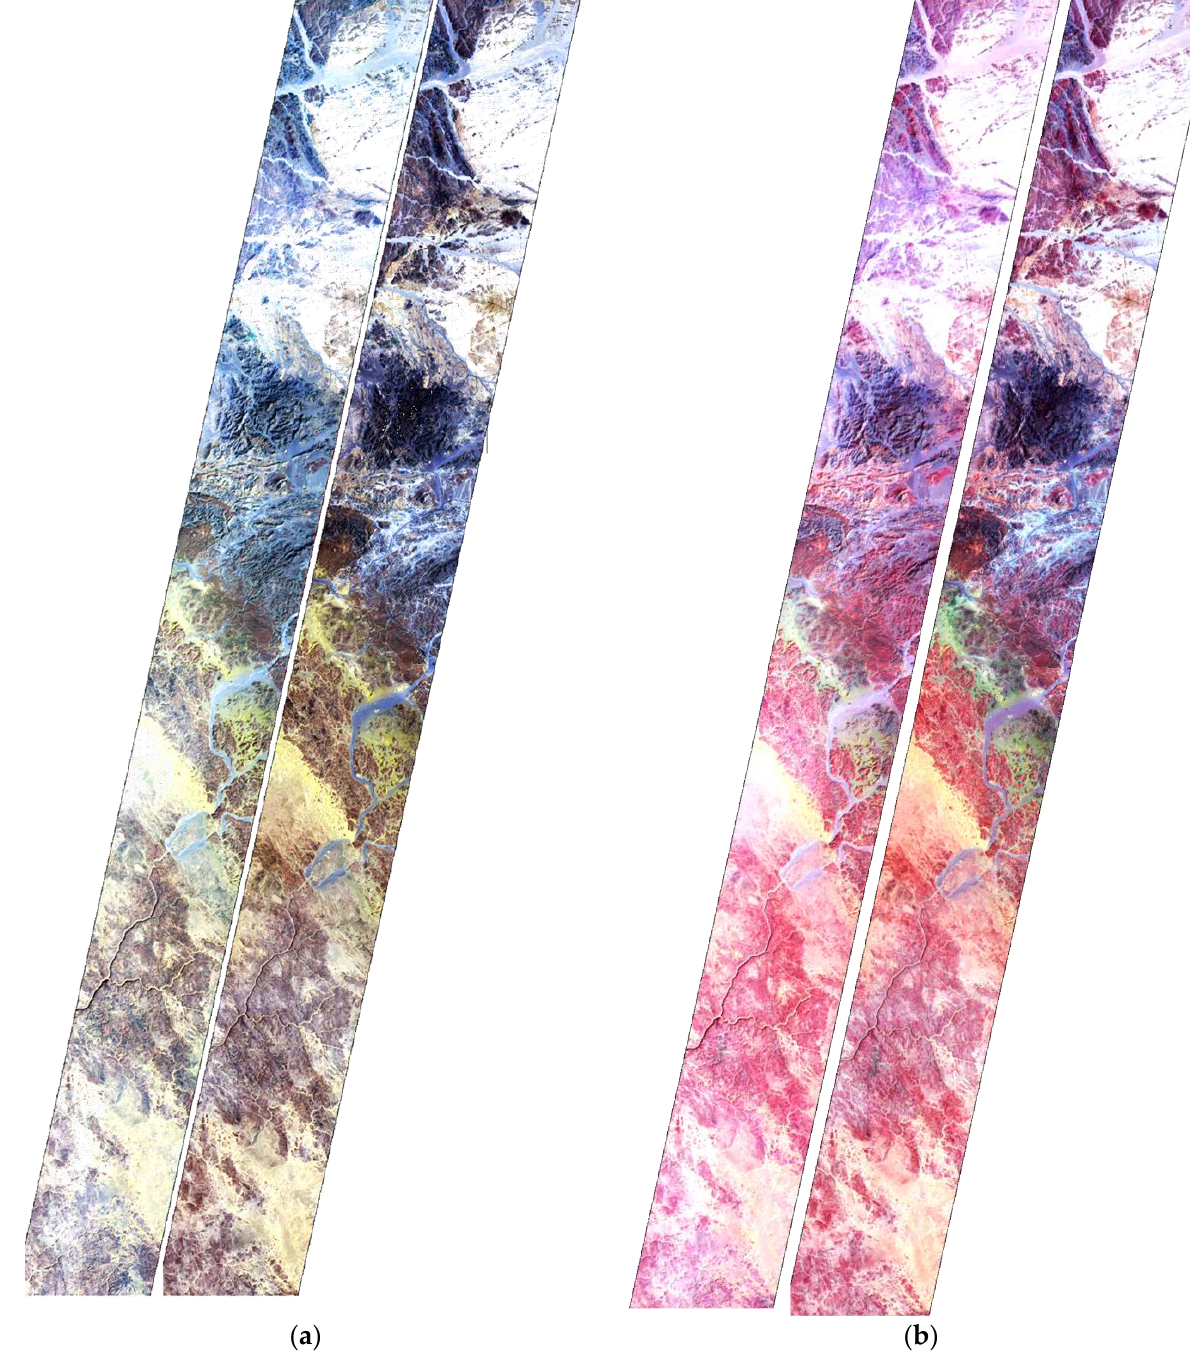
Figure 6. Composite, original versus predicted, ( a ) (R = 83, G = 35, B = 16) and ( b ) (R = 146, G = 30, B = 13).